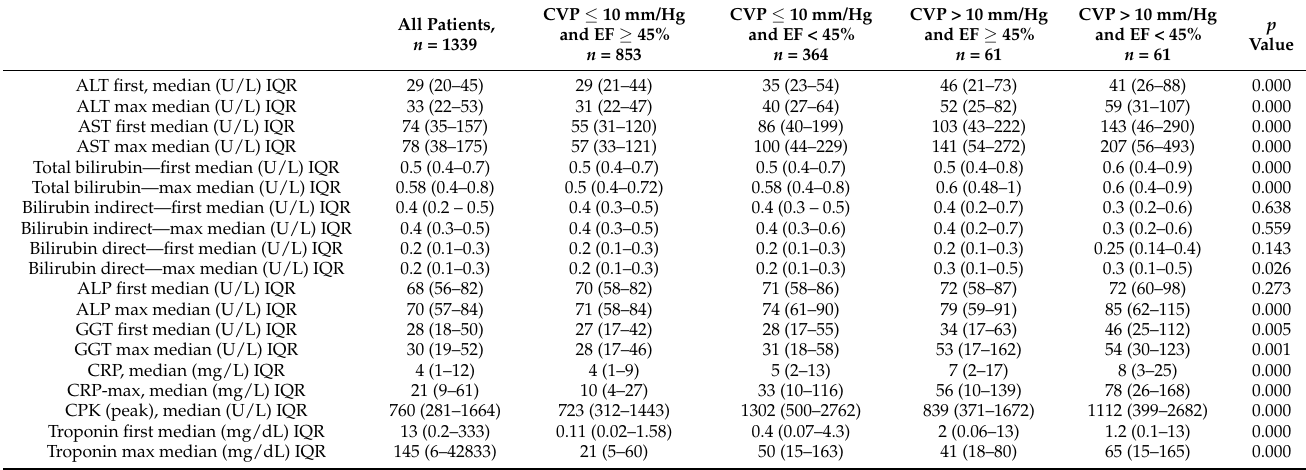
Table 2. Patients’ baseline and peak liver function tests as well as cardiac biomarkers in each subgroup.Using propensity score matching, we found significantly higher levels of ALT, ALKP and GGT in the group with the worst cardiac function parameters compared to controls. Level of AST was also higher in that group, although not